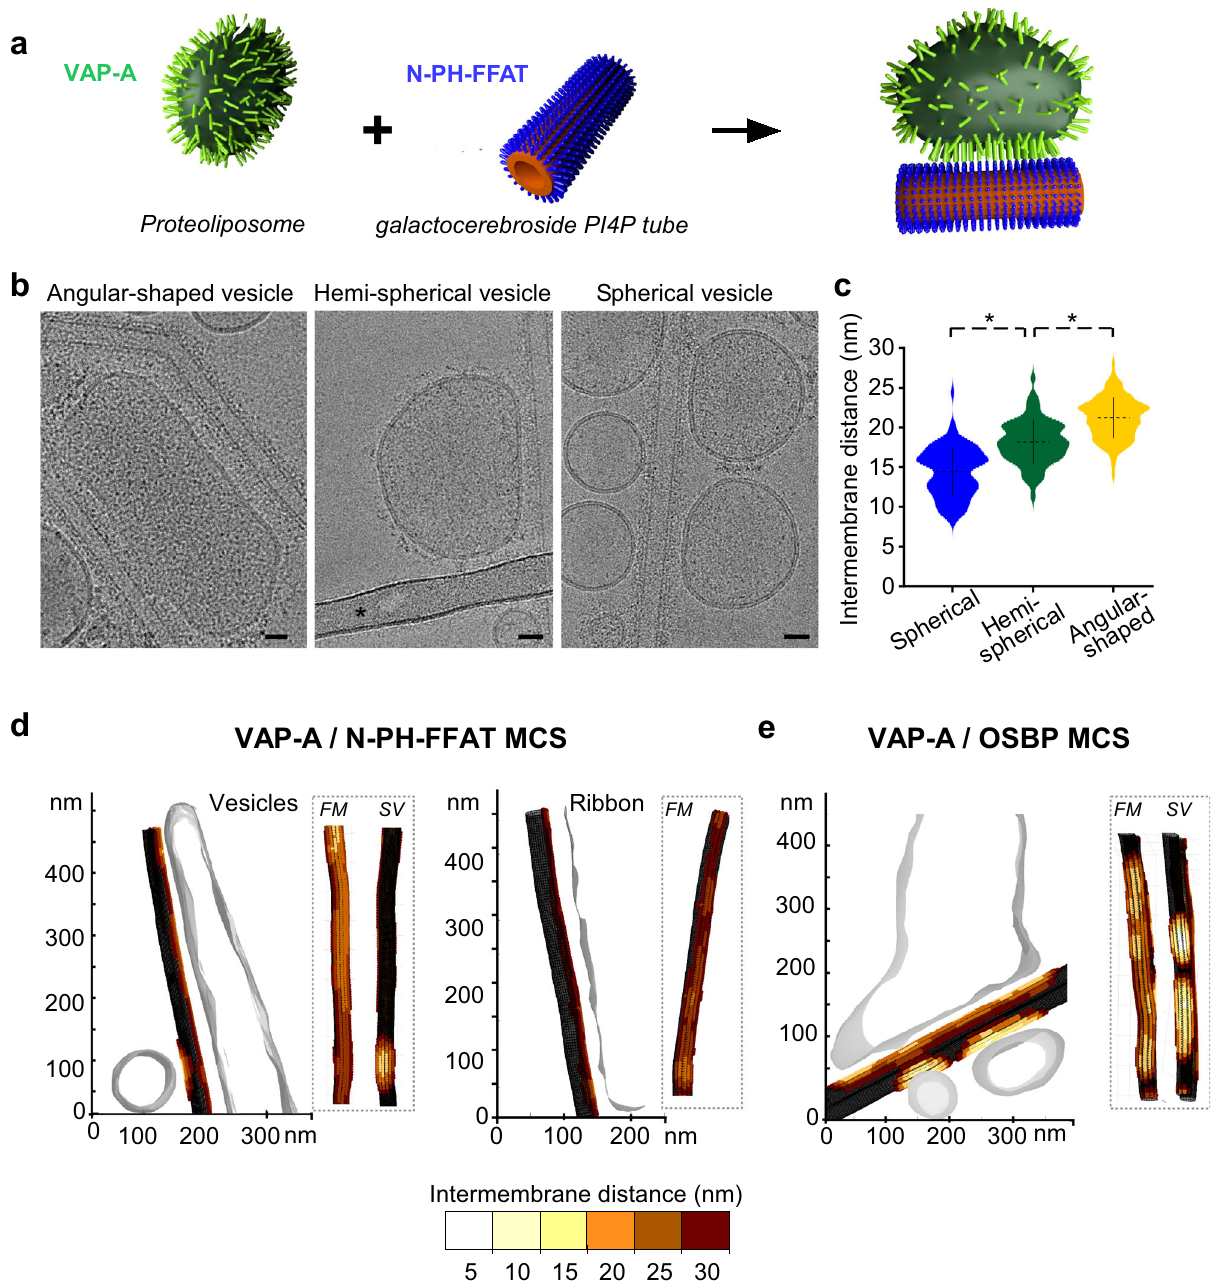
Fig. 2 VAP-A density tunes the separation between facing membranes in reconstituted membrane contact sites (MCS). a Scheme of the reconstitution of MCS between VAP-A proteoliposomes and N-PH-FFAT (or OSBP) bound to galactocerebroside tubes doped with PI4P. b Representative images of the different types of contacts made between VAP-A proteoliposomes (lipid/protein ratio LPR 70 mol/mol) and N-PH-FFAT bound to tubes. The bar labeled with * in the central panel is a carbon grid bar. Bars = 25 nm. c Violin plots of the distance between facing membranes in reconstituted MCS (LPR 70 mol/mol). The plots show the complete distribution of values analyzed. The horizontal and vertical lines show the average value and the standard deviation, respectively. ∗ indicates p < 0.01 by unpaired t test. Intermembrane distance between tubes and spherical vesicles ( n = 90), hemispherical vesicles ( n = 122), and angular-shaped vesicles ( n = 128) were analyzed. d 3D reconstruction of VAP-A/N-PH-FFAT and e VAP-A/ OSBP MCS from cryo-tomograms. Distances between angular shape and spherical vesicles and tubes and ribbons and tubes are depicted in color codes on tubes. FM indicates the tube side in contact with a fl attened region of large vesicles and SV the tube side in contact with small spherical vesicles. Figure 2c. Type of analysis, unpaired (independent), two-sided (two tails), t test, valid for all plots. p p value, CI con fi dential interval. Plot spherical vs hemispherical vesicles: p = 3.9588e-1, CI [ − 4.5561, − 2.9464]. Plot hemispherical vs angular-shaped: p = 1.3549e-20, CI = [ − 3.6377, − 2.4378]. A representative micrograph or result is shown from at least three